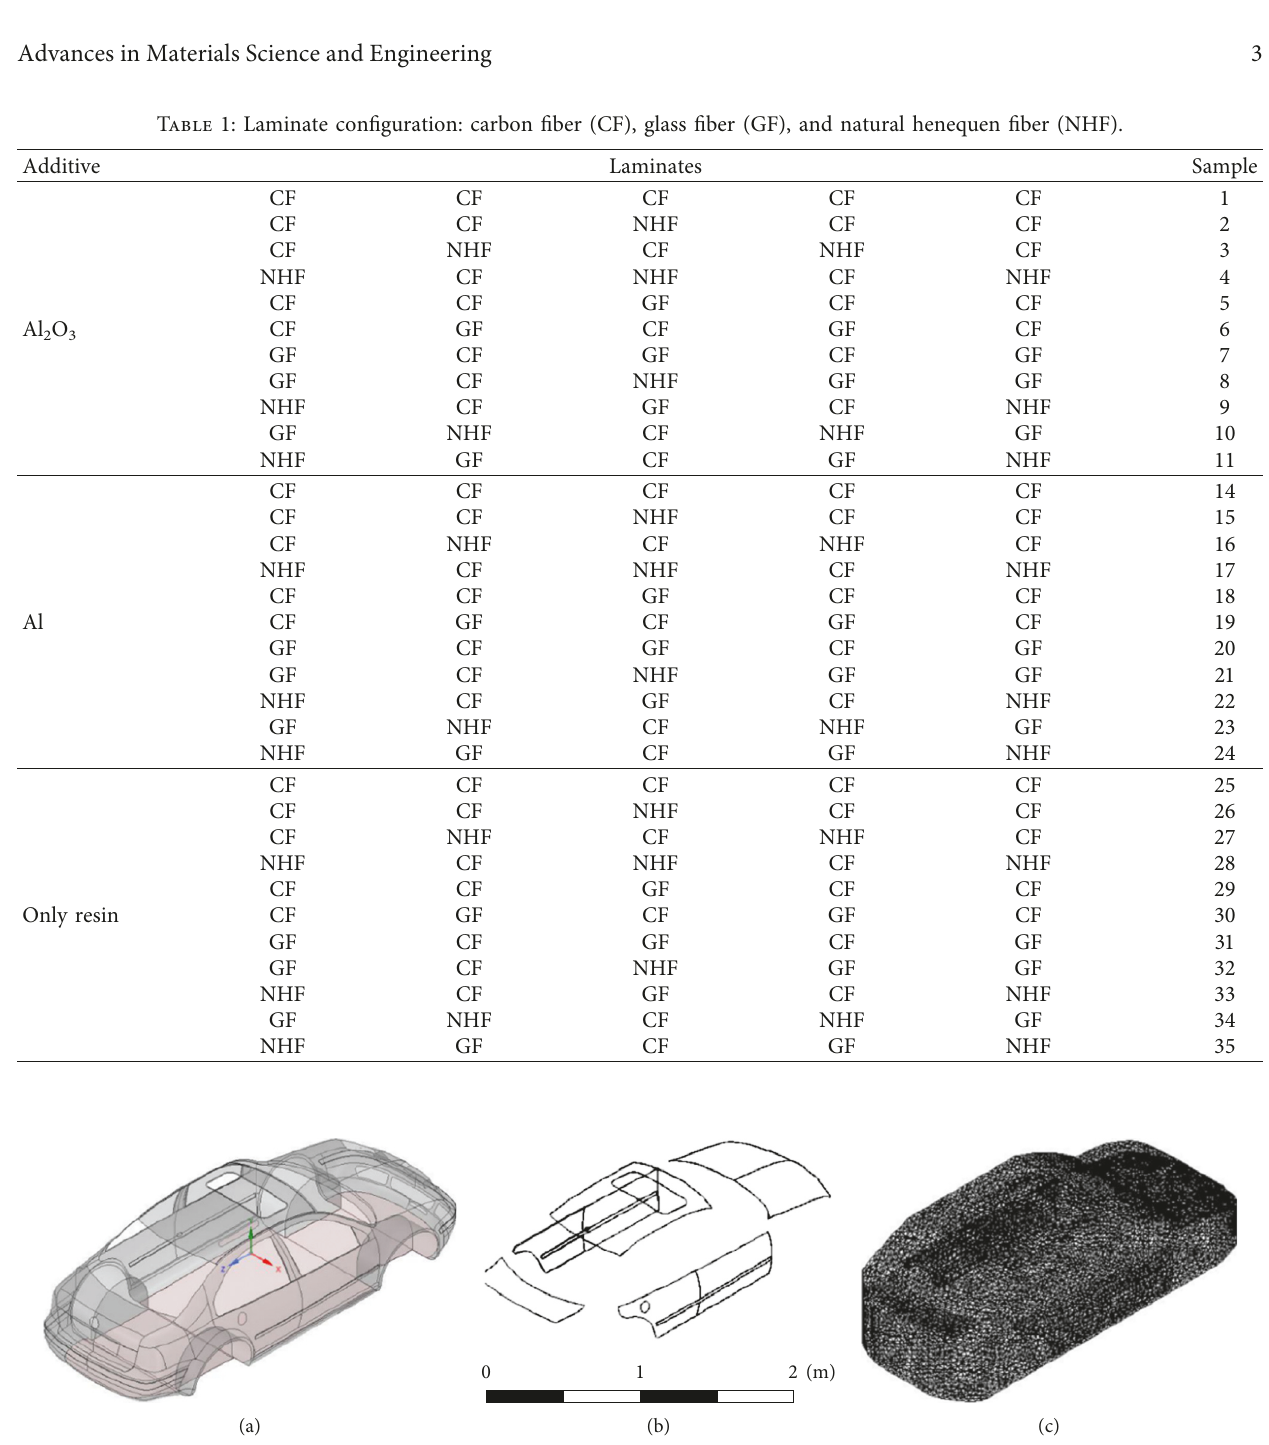
Figure 1: System mesh: (a) system surfaces, (b) surfaces considered for heat transfer, and (c) mesh